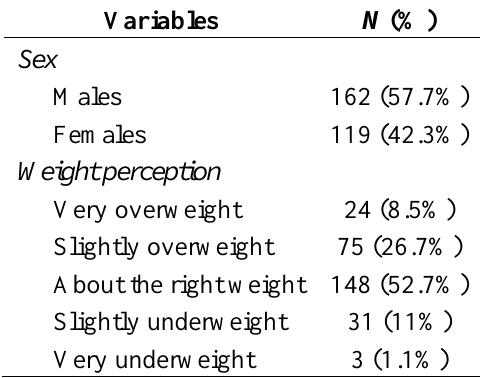
Table 1. Descriptives statistics. Categorical variables ( n =